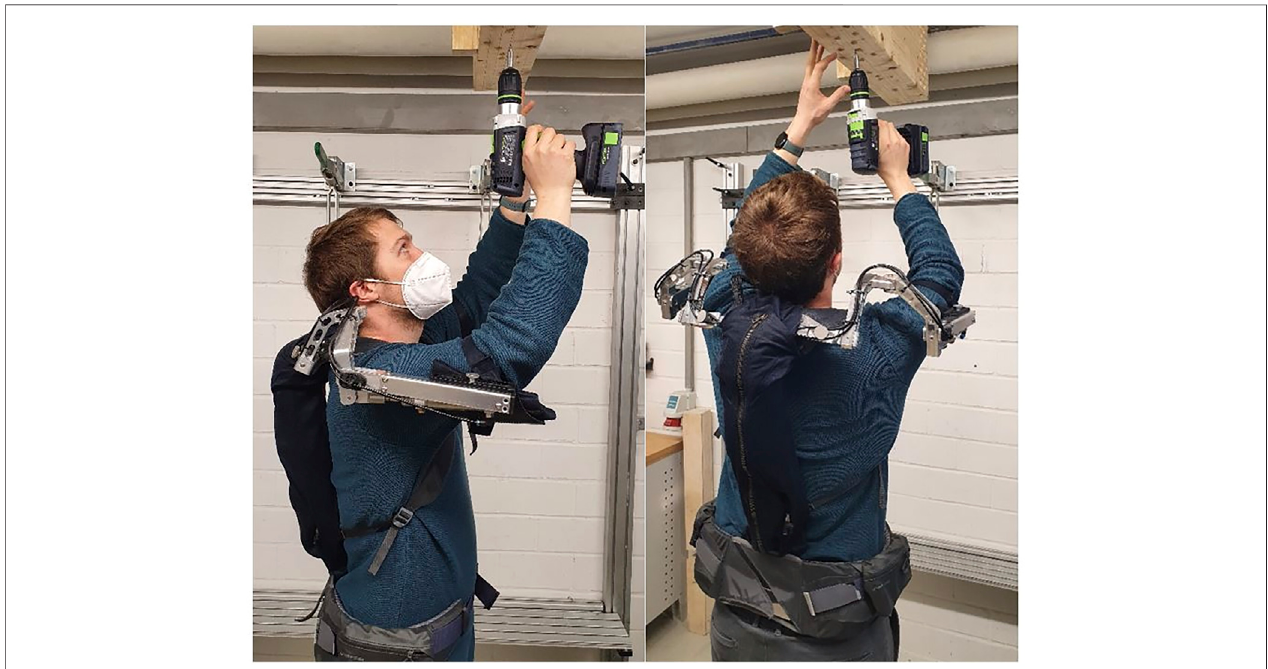
FIGURE 1 | “ Lucy ” exoskeleton for over head work (e.g., Yao et al., 2021).